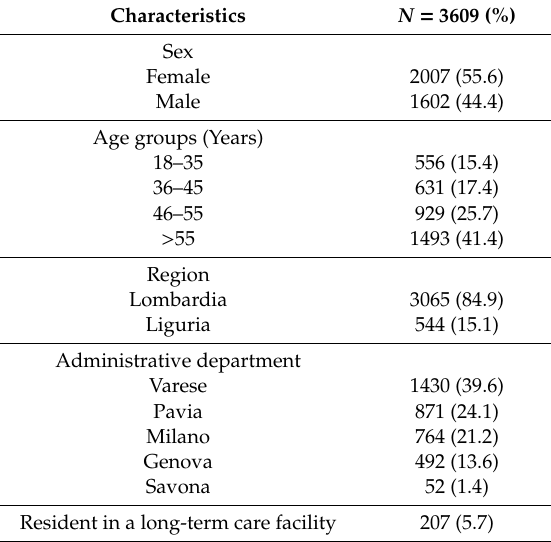
Table 1. Clinical characteristics of the study population.